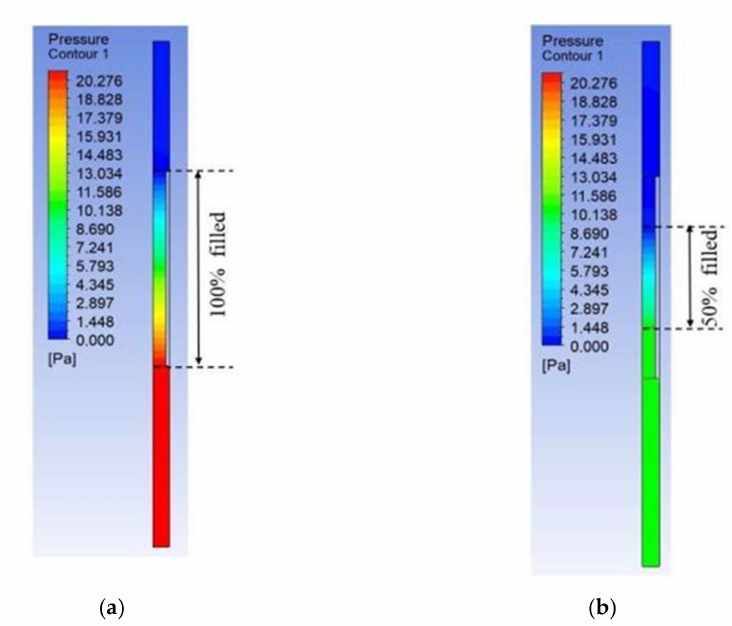
Figure 8. ( a ) Pressure contours of 100% thickness of 0.95 porosity 10 PPI foam. ( b ) Pressure contours of 50% thickness of 0.95 porosity 10 PPI